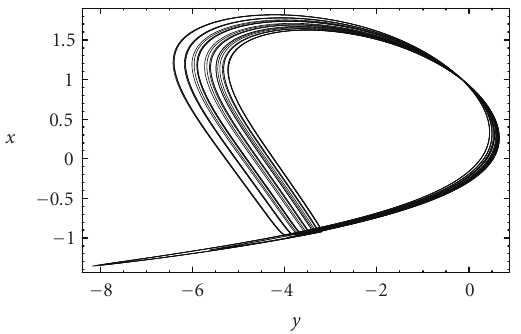
Figure 2.17. Projection of the three-dimensional trajectory onto the yx -plane ( I = 3 . 25, r = 0 . 005, and s = 4 .